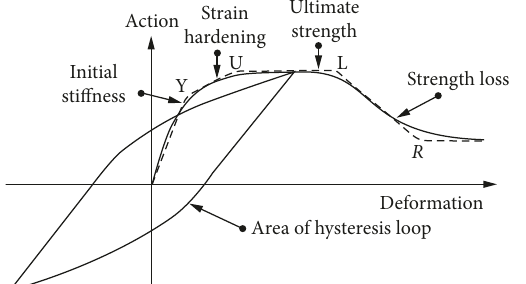
Figure 6: Main aspects of inelastic behavior in Perform-3D [19, 20].